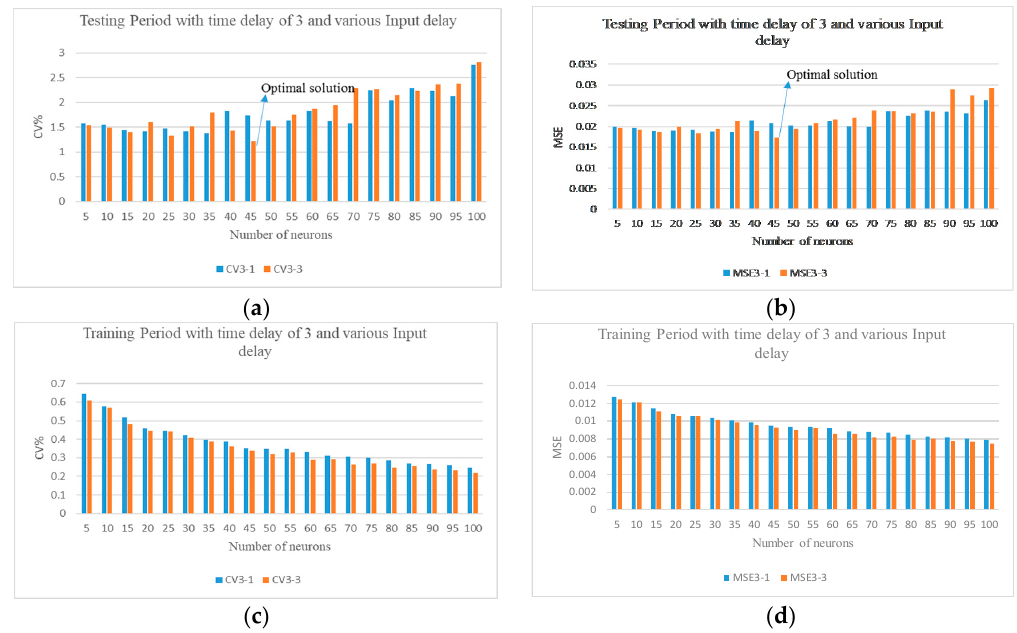
Figure 6. ( a ) Coefficient of variation (CV%) results for the testing period; ( b ) mean square error MSE results for the testing period; ( c ) CV% results for the training period; and ( d ) MSE results for the training period.